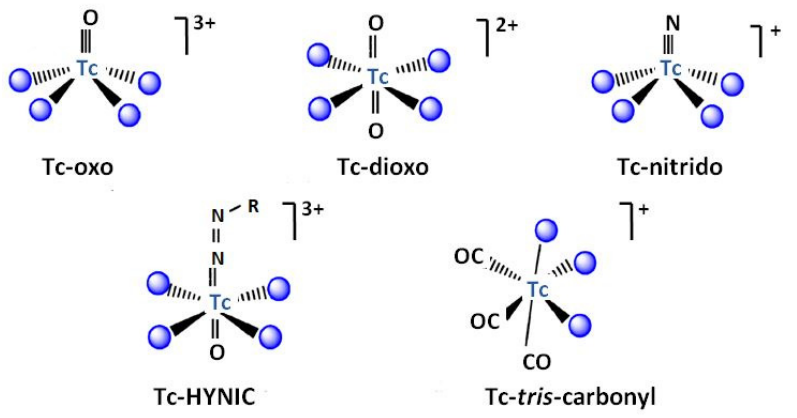
Figure 1. Technetium inorganic fragments used for labeling bioactive molecules. HYNIC- 6-hydrazinonicotinamide. Adopted from [48].